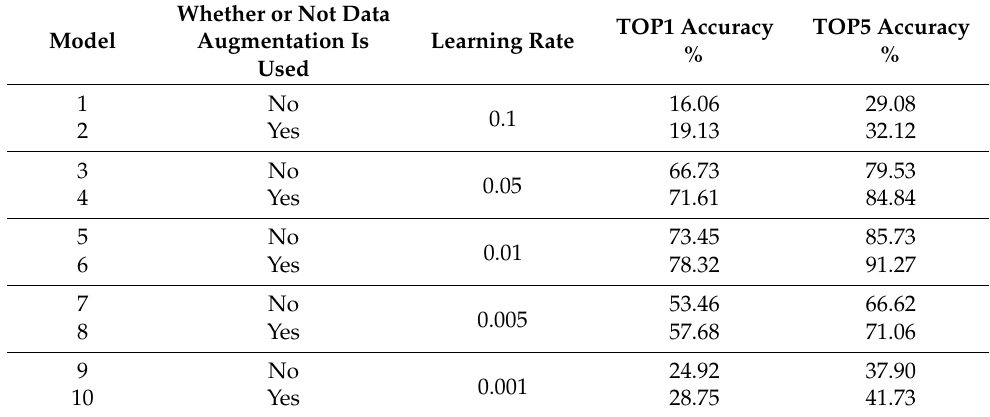
Table 3. Comparison of classification accuracies for grassland-type recognition models.